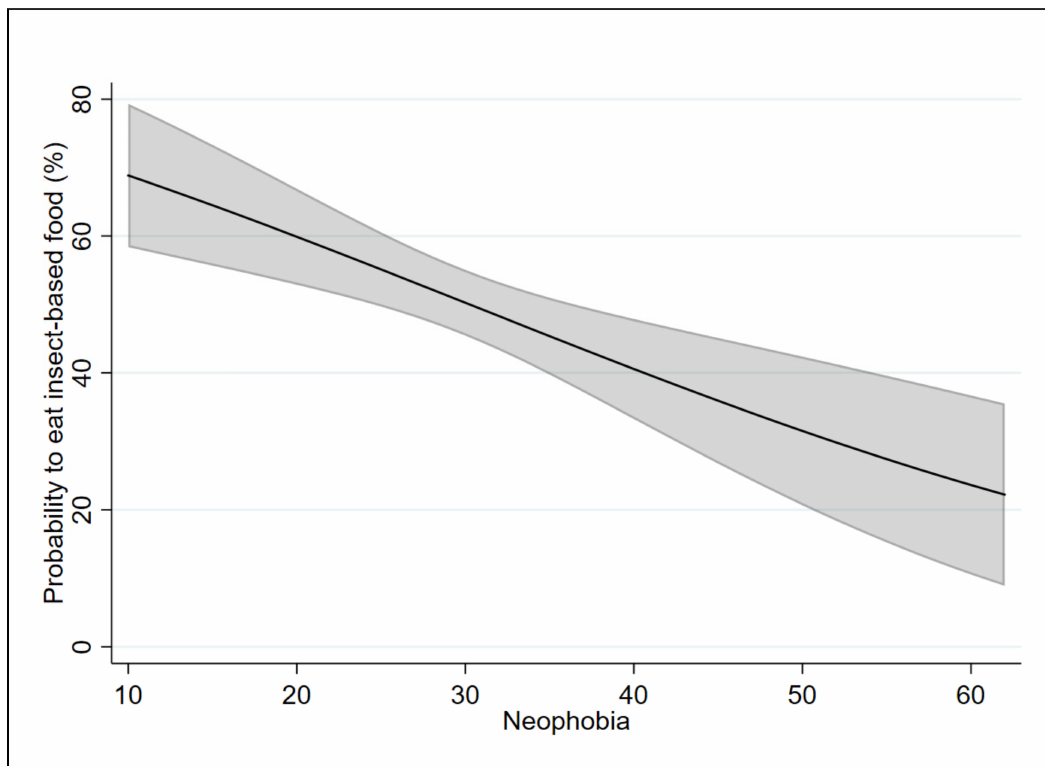
Figure 1. Marginal effects of the neophobia scale on Model 1 with 95% confidence intervals.